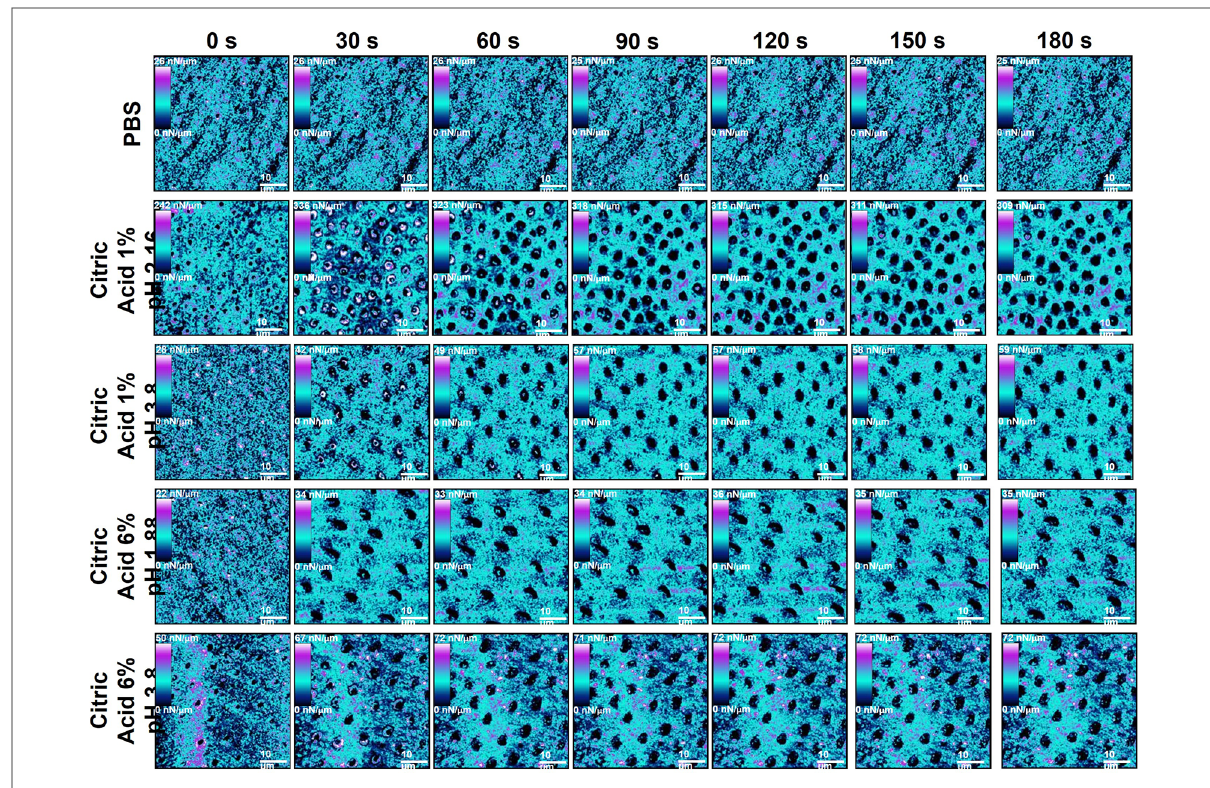
FIGURE 4 Showing example stiffness AFM mapping of human dentine exposed to all dietary solutions (top) throughout the exposure regime starting from 0 s (top) to 180 s (bottom) at 30 s